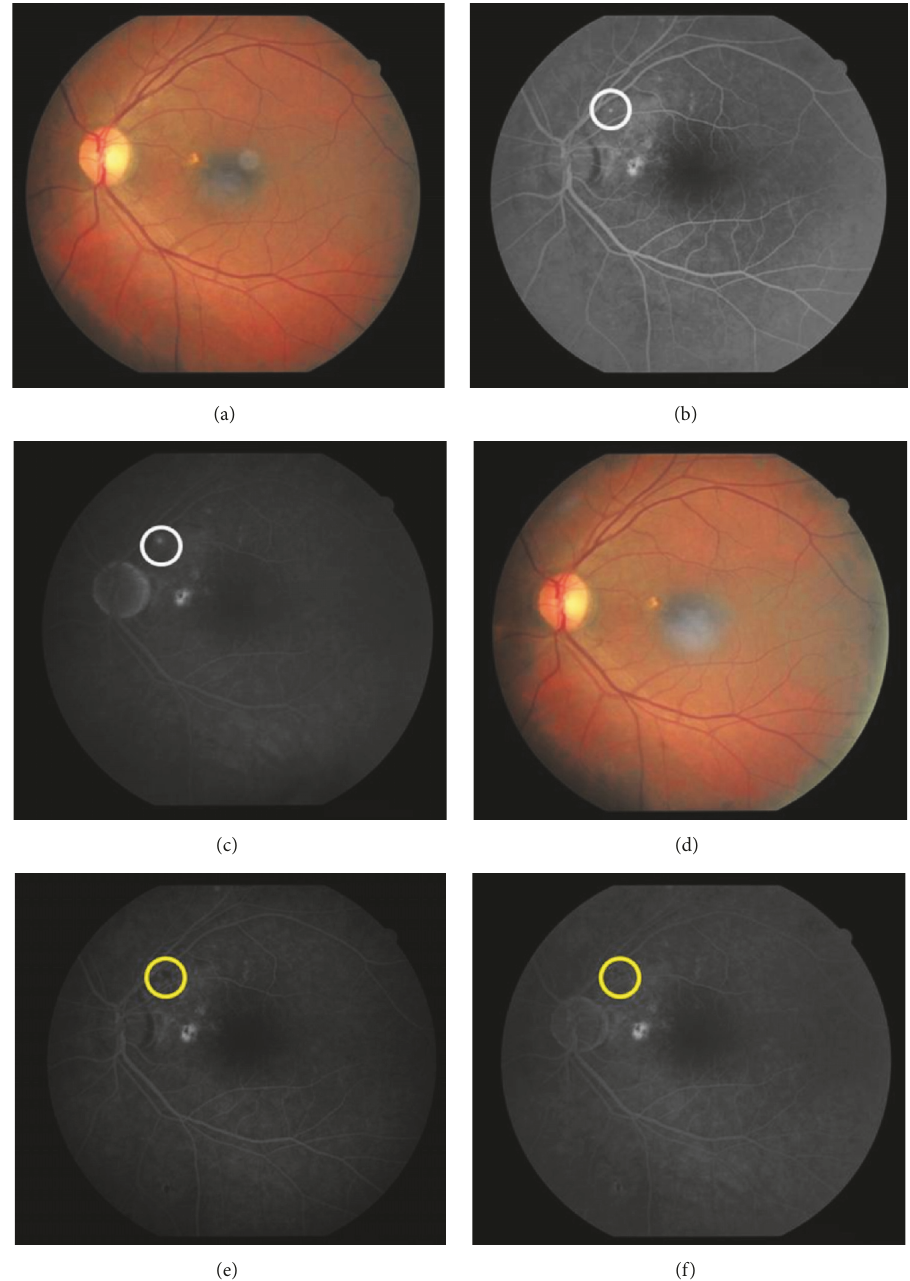
Figure 2: Left eye pre- and posttreatment fundus images, FFA and OCT scans . (a) Pretreatment color fundus image showing RPE alterations over papilla-macular bundle. (b) and (c) Pretreatment FFA with transmission defects and ink blot hyperfluorescence (white circle). (d) Posttreatment color fundus image showing RPE alterations suggestive of resolved CSCR. (e) and (f) Posttreatment FFA showing healed CSCR with no leakage (yellow